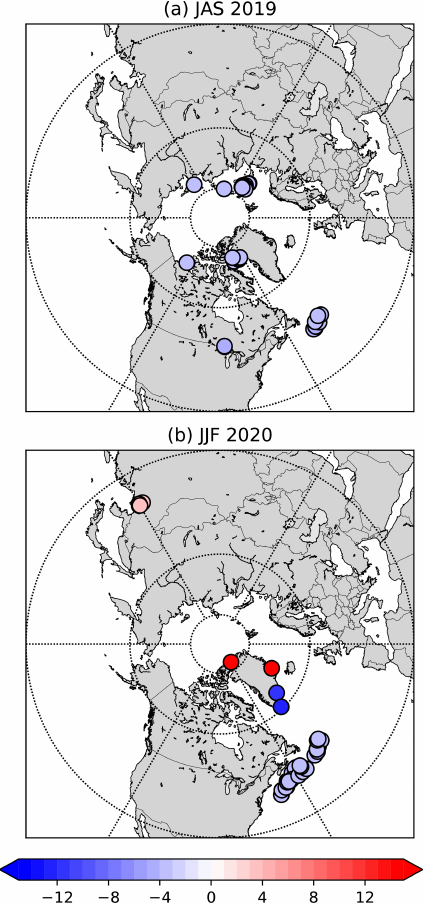
Figure 4. Difference in the skin temperature analysis in observa- tion space (in K) between the experiment and the control when the difference exceeds 3 background error standard deviations and for NOAA-20-ATMS. Bluish colours denote SKTECV values lower than TOVSCV values, and reddish colours denote SKTECV val- ues greater than TOVSCV values. The time periods shown are (a) JAS 2019 and (b) JFM 2020.